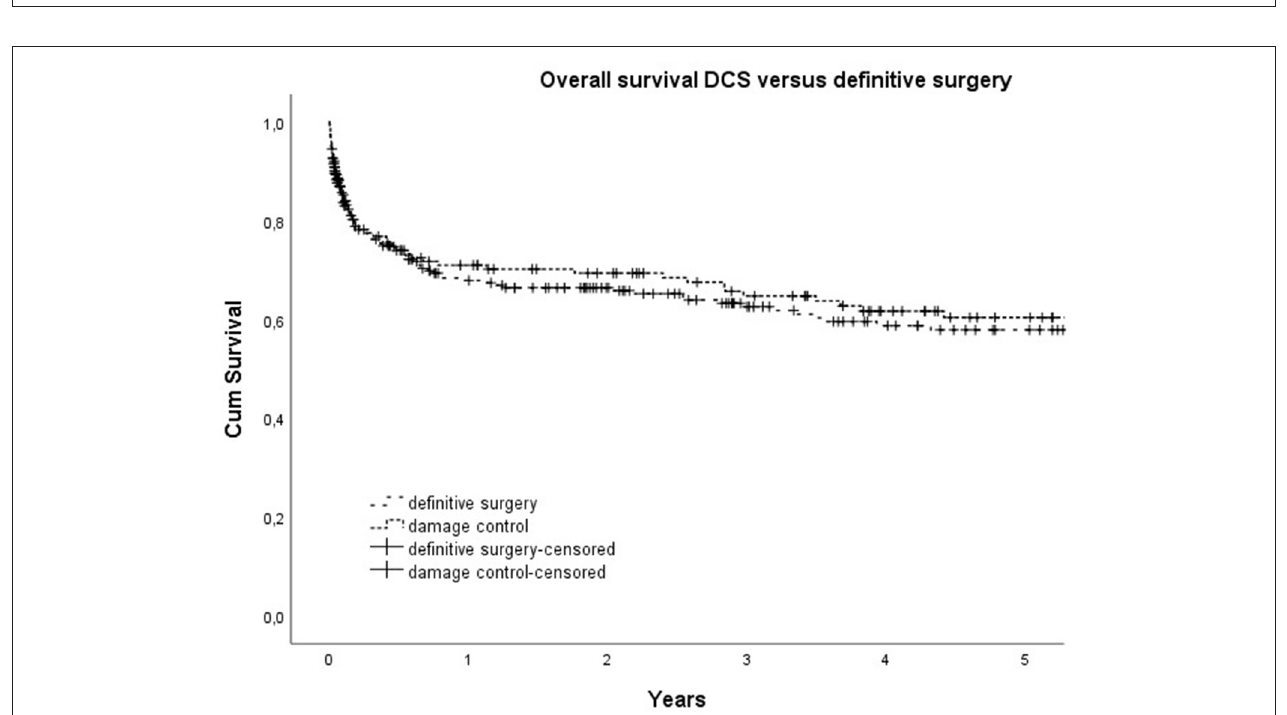
FIGURE 2 | Overall survival for Damage control surgery (DCS) versus definitive